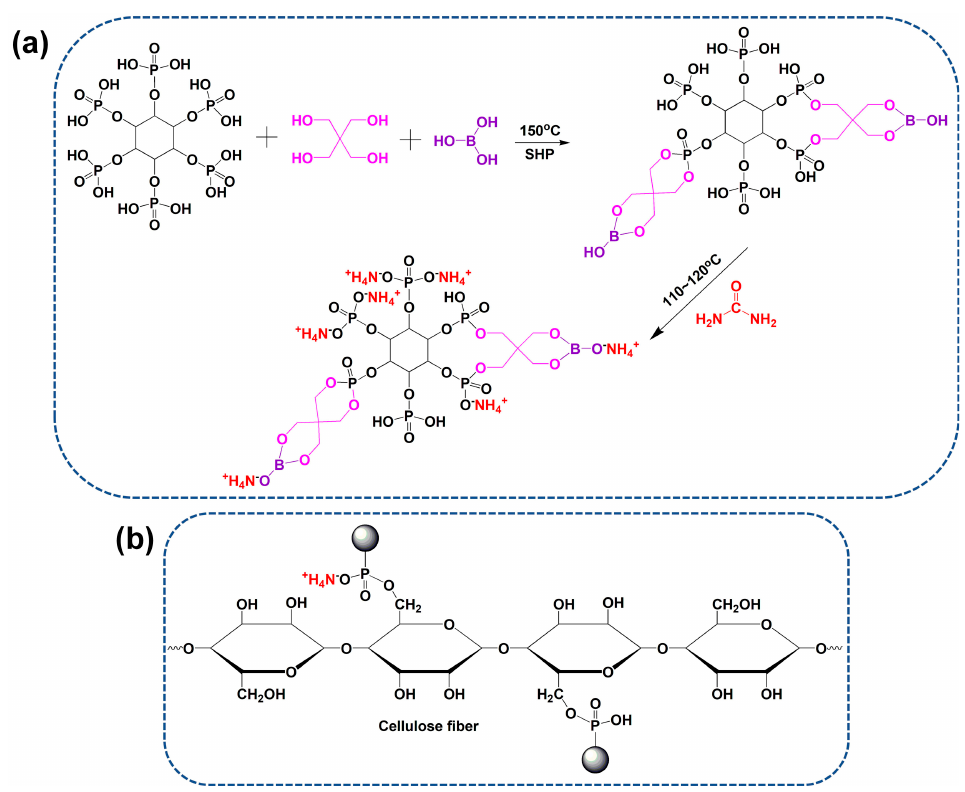
Figure 1. Synthesis route of IFR agent ( a ) and its cross ‐ linking action with cellulose fiber (b).